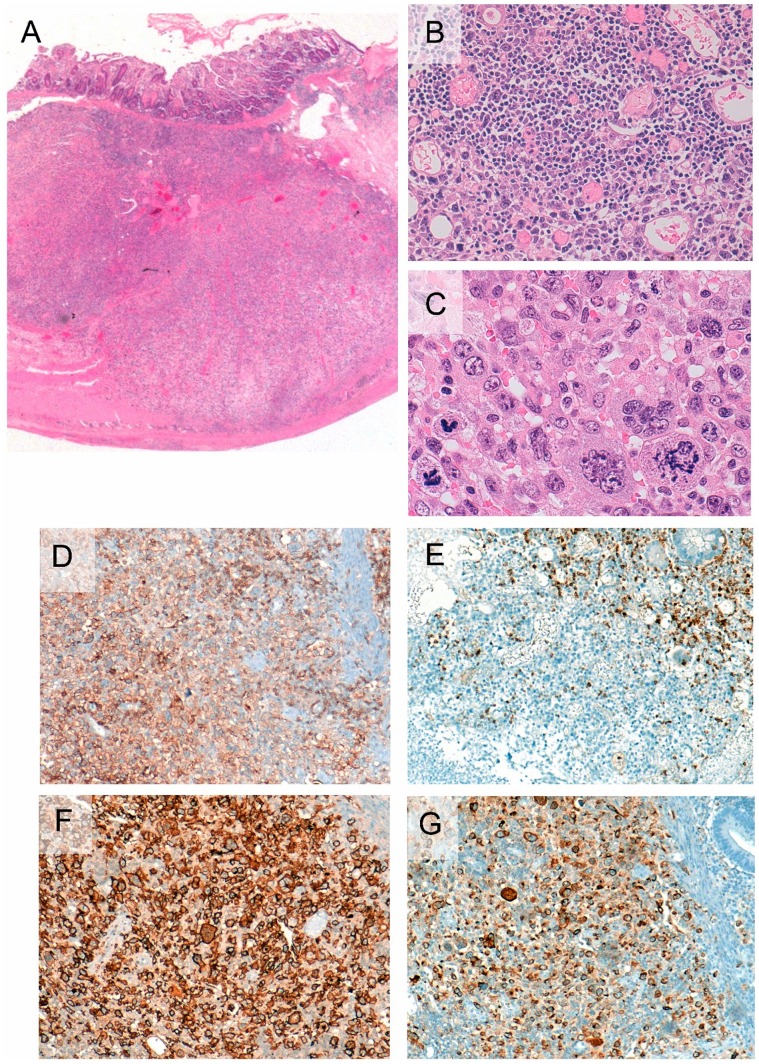
Section from a small intestinal resection specimen showing large cell transformation (Case 2).Transmural infiltrate of neoplastic lymphocytes is observed (A). The lamina propria shows admixtures of small and large atypical lymphocytes, including bizarre and multinucleated forms (B and C). The large lymphocytes express CD4 (D), CD30 (F) and granzyme B (G) and lack CD5 expression (E).